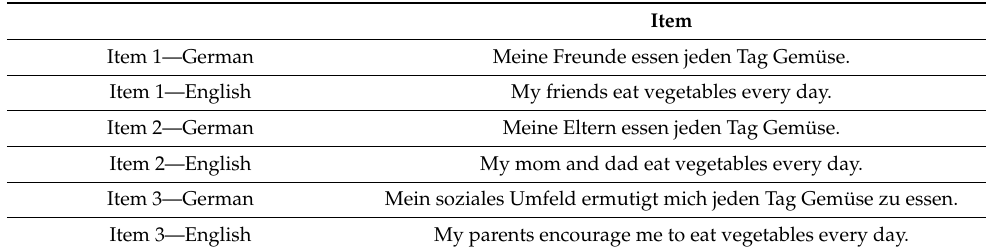
Table A1. Cont . Item I think it would be acceptable to advertise vegetable Priming and salience nudge consumption in the cafeteria using posters on which for English 1 example skinny individuals were displayed. - I think it would be acceptable if the school encouraged me to sign up for a “6 a day” or “I love vegetables” club to make me feel obligated to eat more vegetables. - I think it would be acceptable if the canteen had posters showing happy and popular teenagers eating vegetables and a lonely and sad teenager eating unhealthy food in order to make me feel like eating more vegetables.